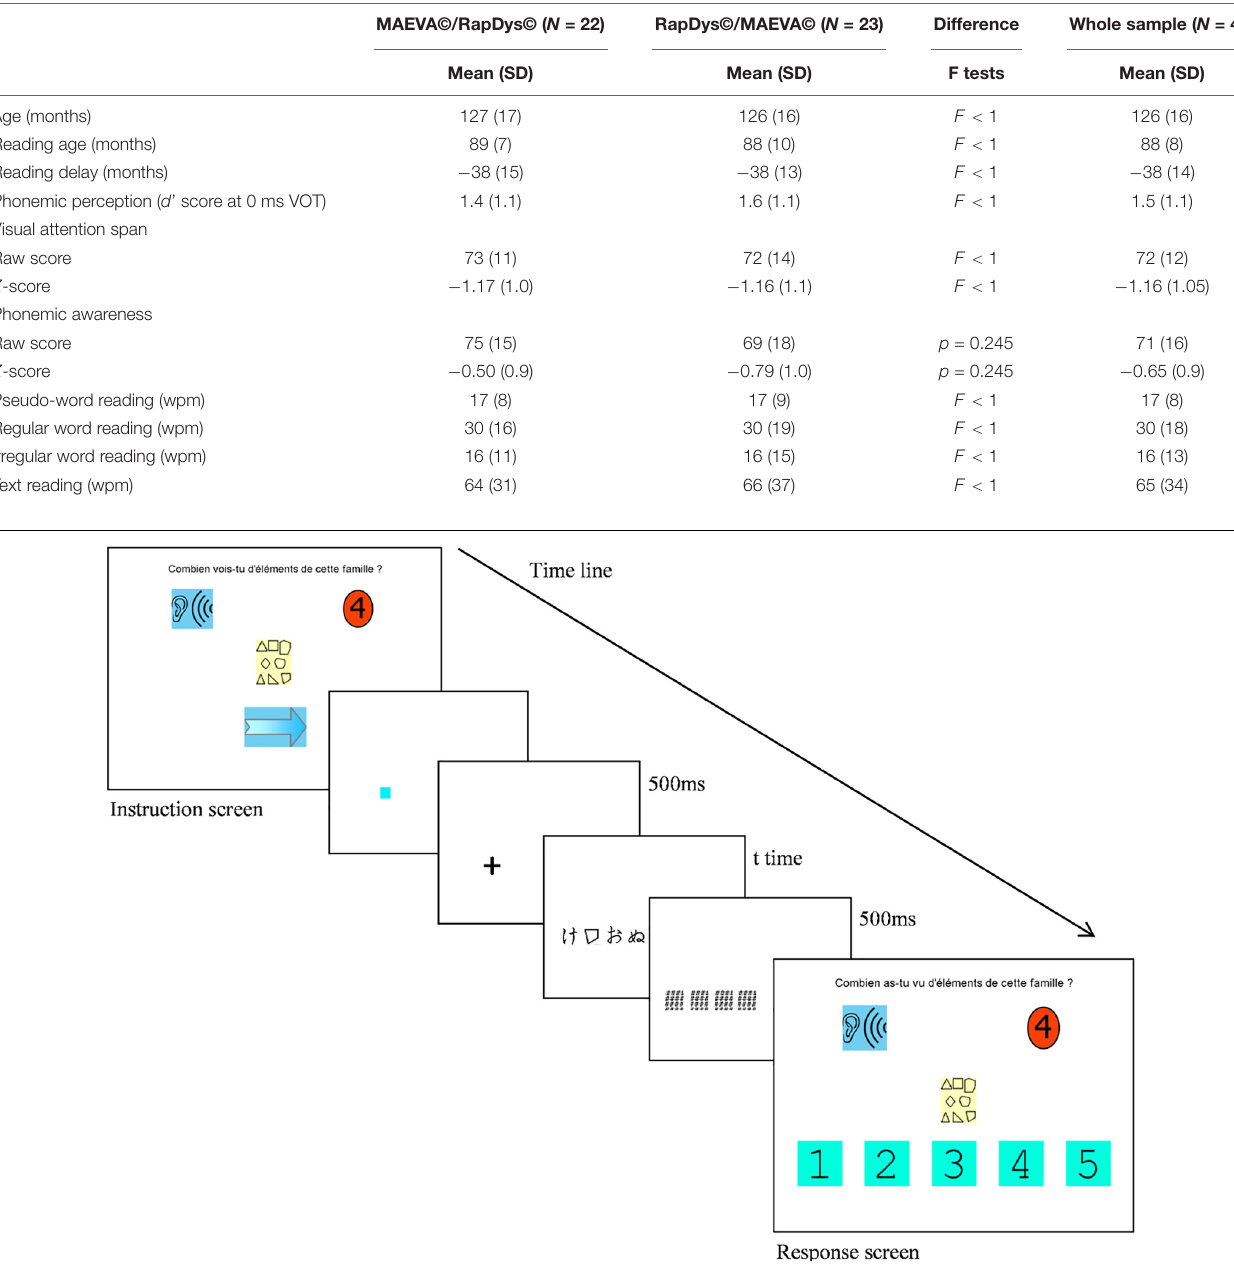
TABLE 1 | Characteristics of the two training groups.